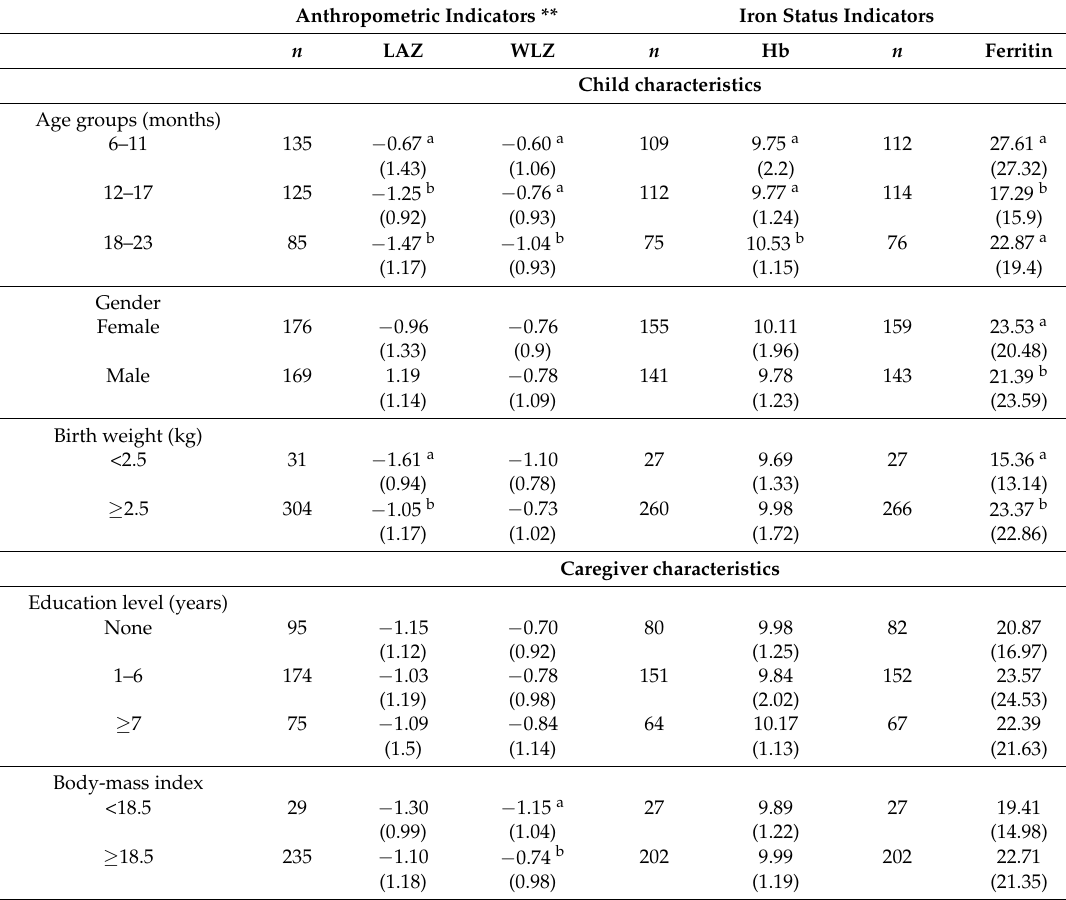
Table 3. Mean ( ± standard deviation/SD) for anthropometric and iron status indicators * by child, caregiver and household